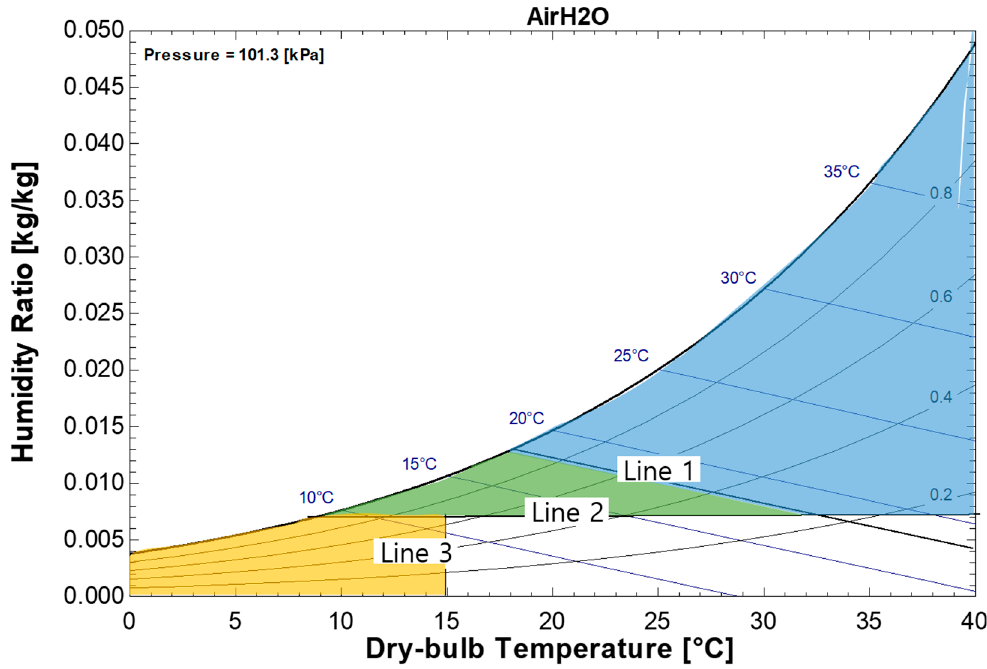
Figure 4. Four regions of psychrometric chart of DOAS.